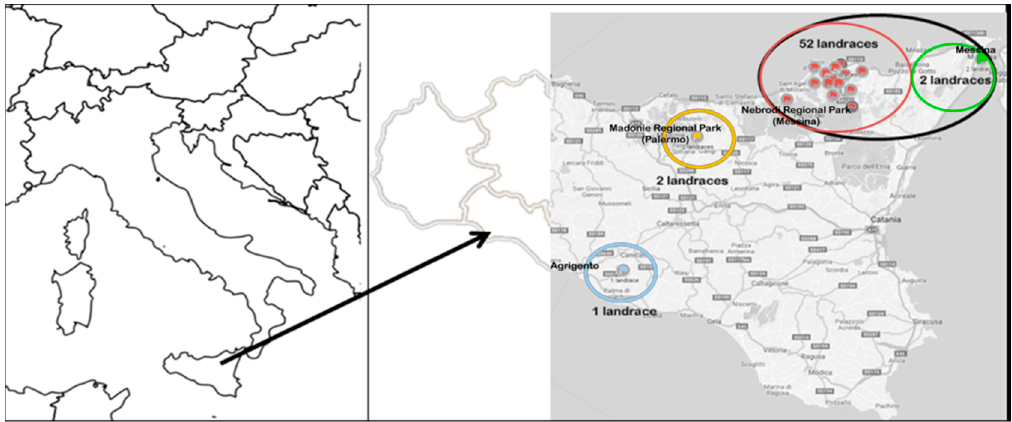
Figure 1. Map of Sicily. Colored circles indicate the di ff erent macro areas where the common bean germplasm was collected.